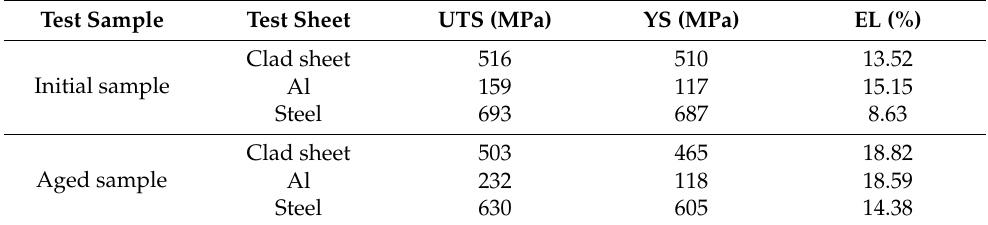
Table 3. Tensile performances of the clad sheets and individual sheets.